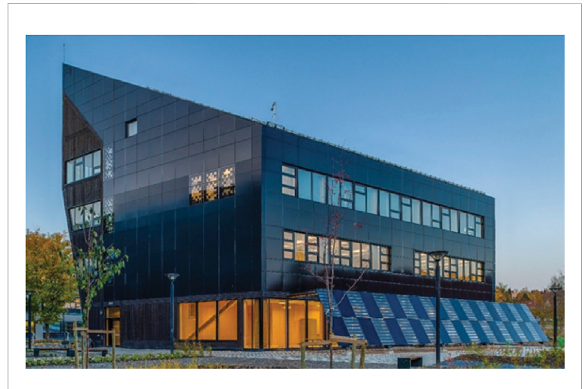
FIGURE 2 ZEB Laboratory: southern and western façade ( © Photo: M.